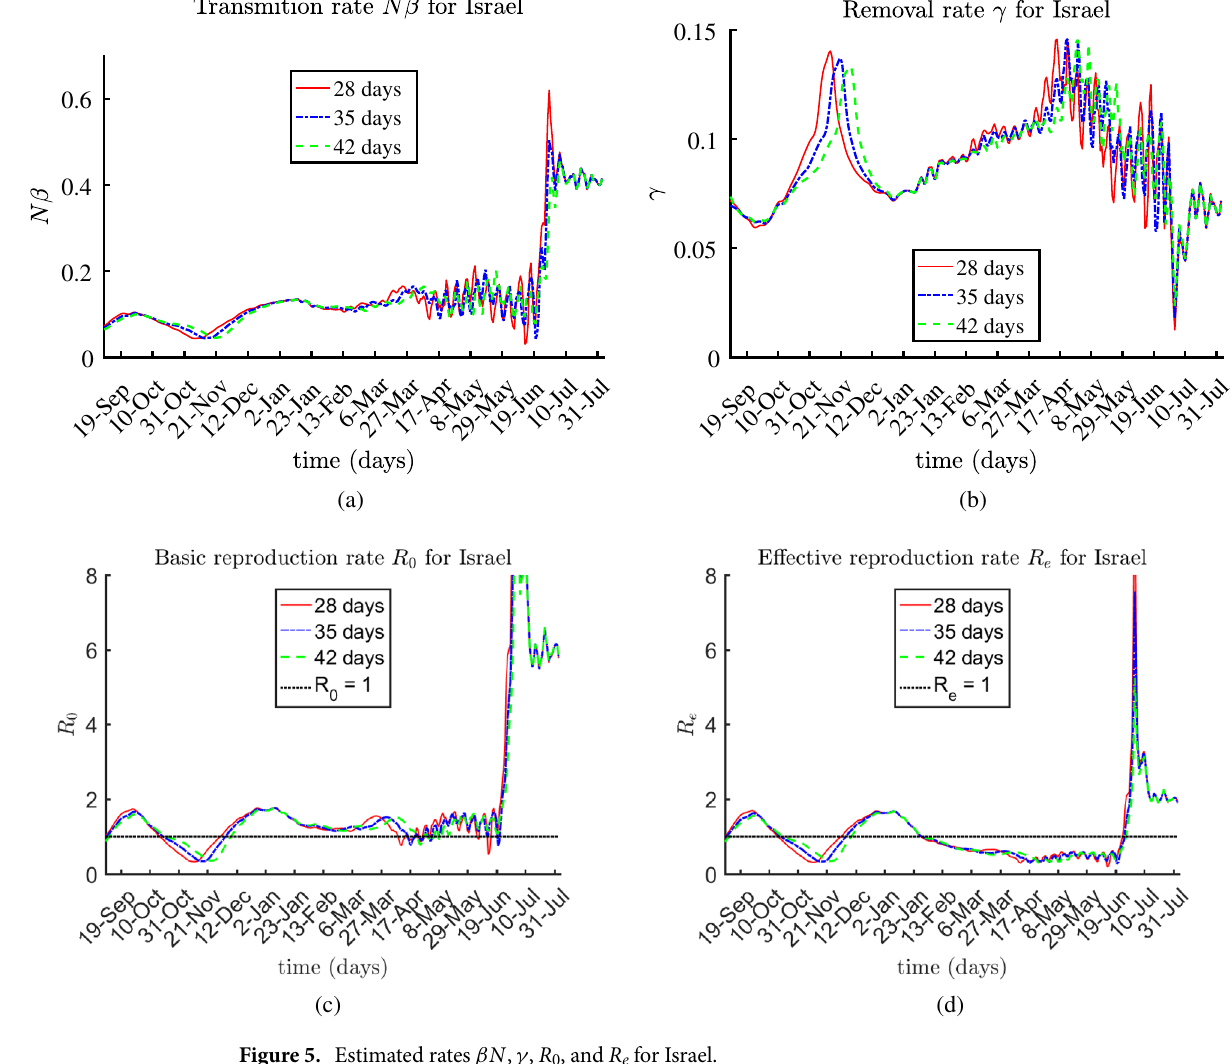
Figure 5. Estimated rates β N , γ , R 0 , and R e for